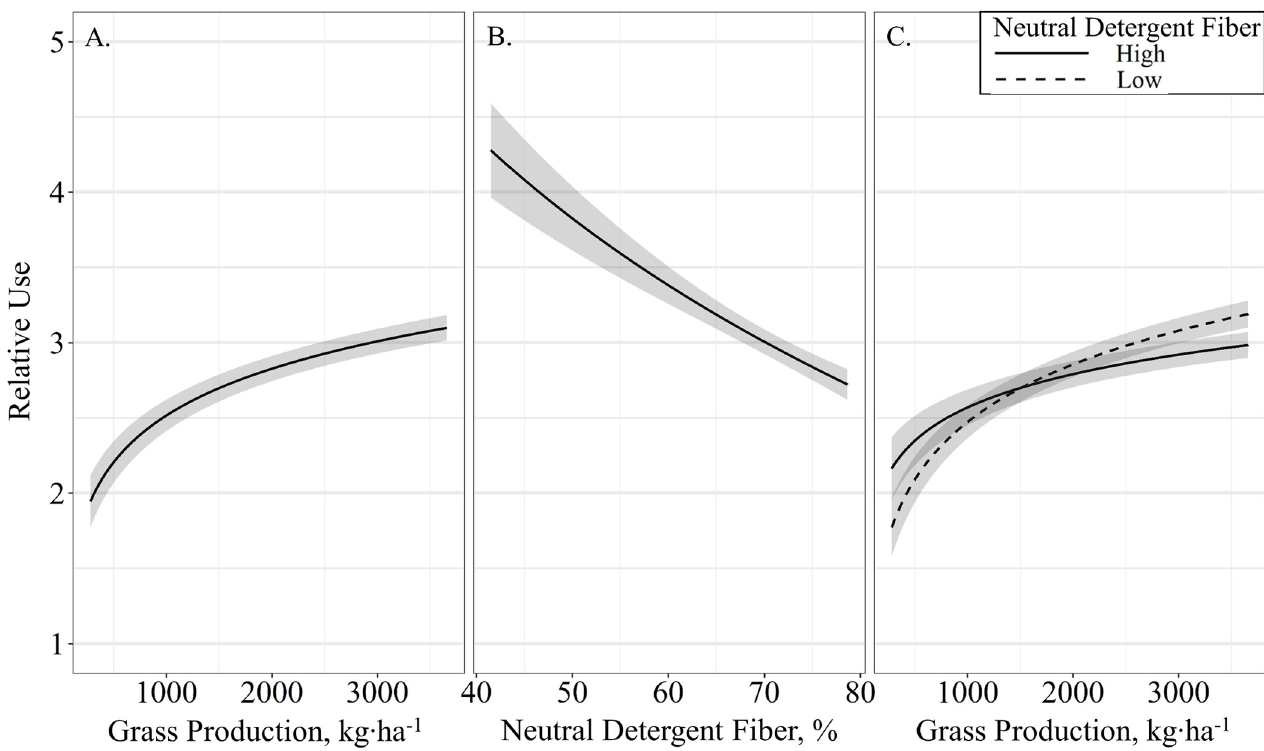
Fig 7. Predicted relationships ( ± 95%CI represented in the shaded area) between ( A ) grass production, ( B ), neutral detergent fiber, and ( C ), the interactions of grass production by neutral detergent fiber on relative resource utilization by cattle grazing dormant northern mixed grass rangeland in 2016 – 2017 & 2017 – 2018 at the Northern Agricultural Research Center Thackeray ranch, Havre, MT.